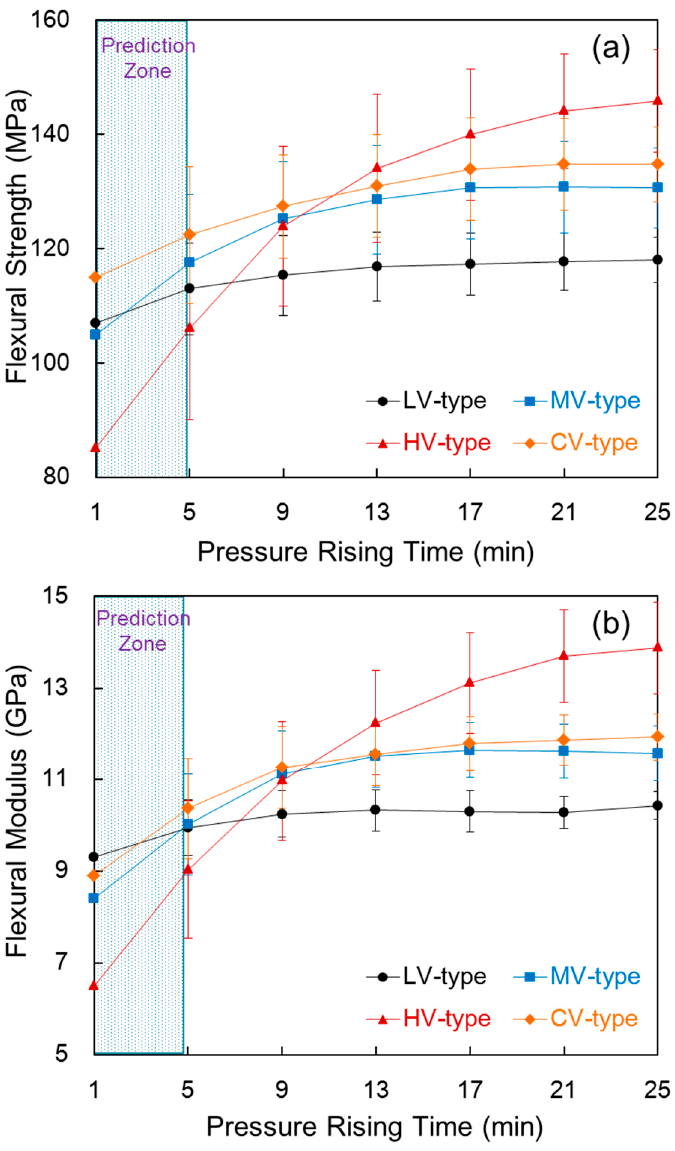
Figure 7. Flexural strength ( a ) and flexural modulus ( b ) of the composite compared with the pressure rising time in each film stacking type.